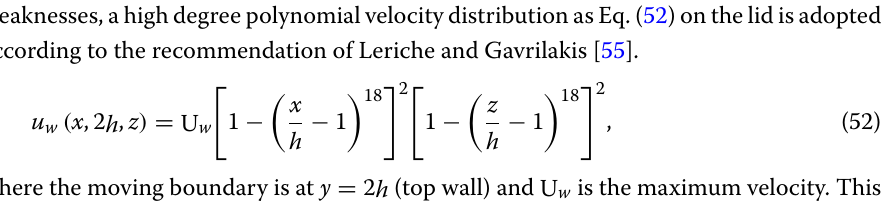
weaknesses, a high degree polynomial velocity distribution as Eq. (52) on the lid is adopted according to the recommendation of Leriche and Gavrilakis [55].